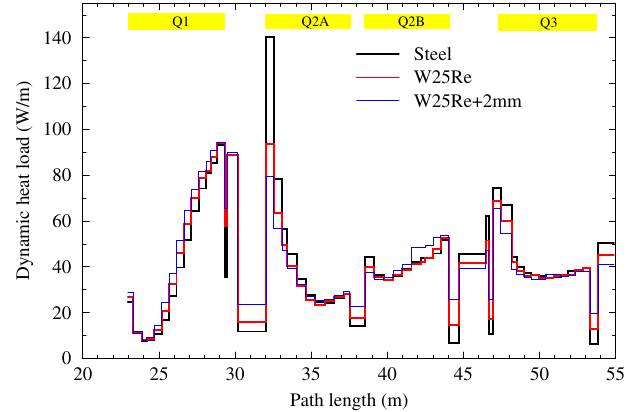
FIG. 12. (Color) Distribution of total dynamic heat load in the 100-mm Nb Sn quadrupoles calculated for the steel and W25 Re 3 liners of baseline thickness as well as for a W25 Re liner of increased